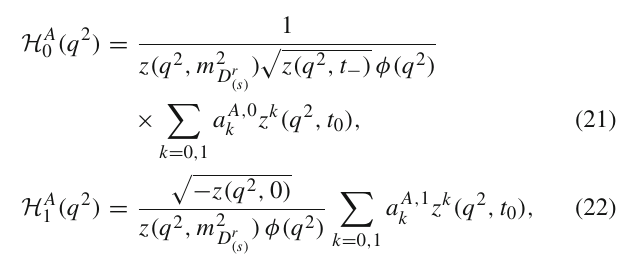
Fig. 2 The contributions of twist-2 and twist-3 distribution amplitudes in the D 0 → a − of q 2 are taken as Fig. 1